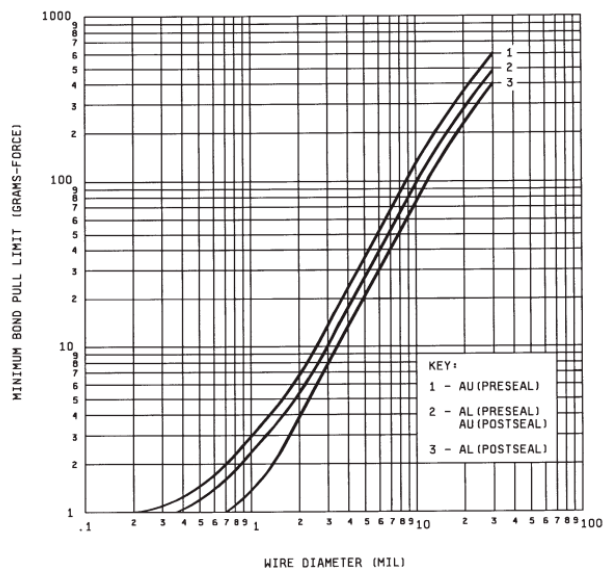
Figure A1. MIL-STD-883F Method 2011.7 Bond Strength (Destructive Bond Pull Test) minimum bond pull limits chart. Note wire diameter in this work was 32 mil (0.81 mm), which corresponds to a minimum bond pull limit of 6000 g-force. Even the weakest interfacial shear strength from Table 3 (1.39 ± 0.56 MPa for CB230-57Bi/42Sn/1Ag solvent-free) has a bond strength of 2260 g-force, which surpasses the minimum bond pull limit.